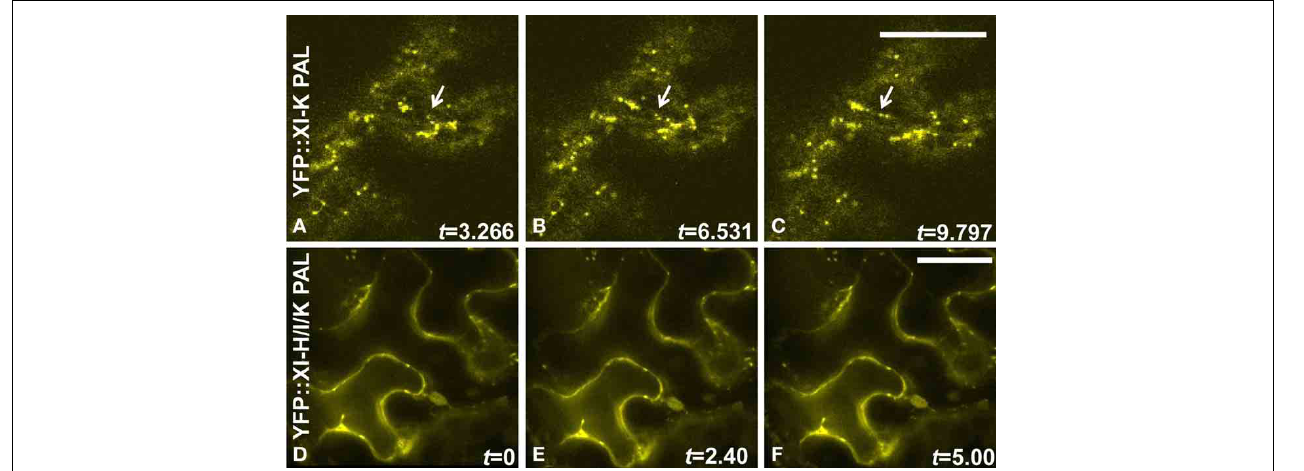
FIGURE 8 | Sequential images indicating movement YFP::At XI-K PAL sub-domain-labeled organelles but lack of movement when multiple domains are infiltrated simultaneously. (A–C) N. benthamiana leaves were infiltrated with an Agrobacterium strain carrying a YFP::At XI-K PAL sub-domain. (D–F) Leaves were infiltrated simultaneously with three